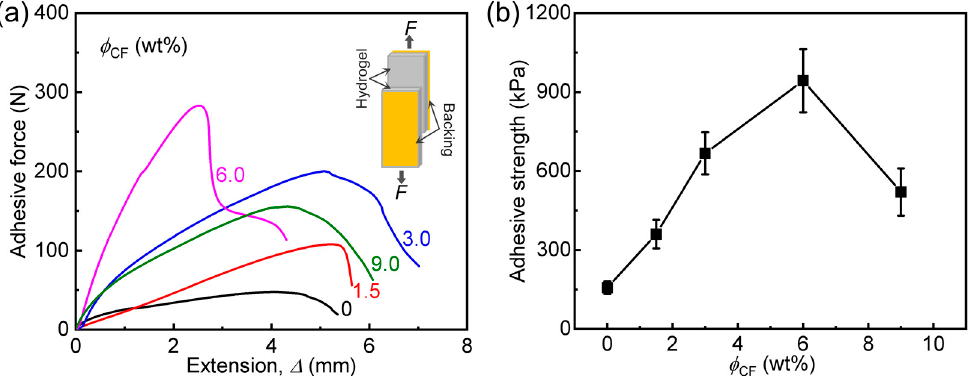
Figure 4. Tearing behavior of PA/CF composite hydrogels with different ϕ CF . ( a ) Tearing force ( F )- extension ( Δ ) curves of the samples. ( b ) Tearing energy versus ϕ CF .